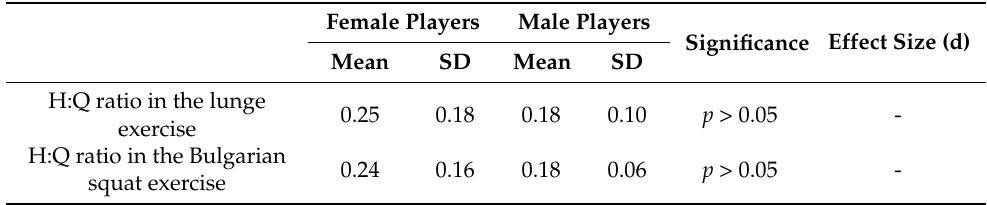
Table 1. Hamstring: quadriceps (H:Q) ratio (mean ± SD). Female Players